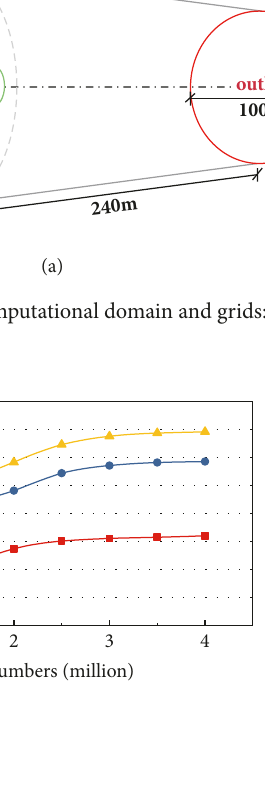
Figure 5: Variations in velocity with grid